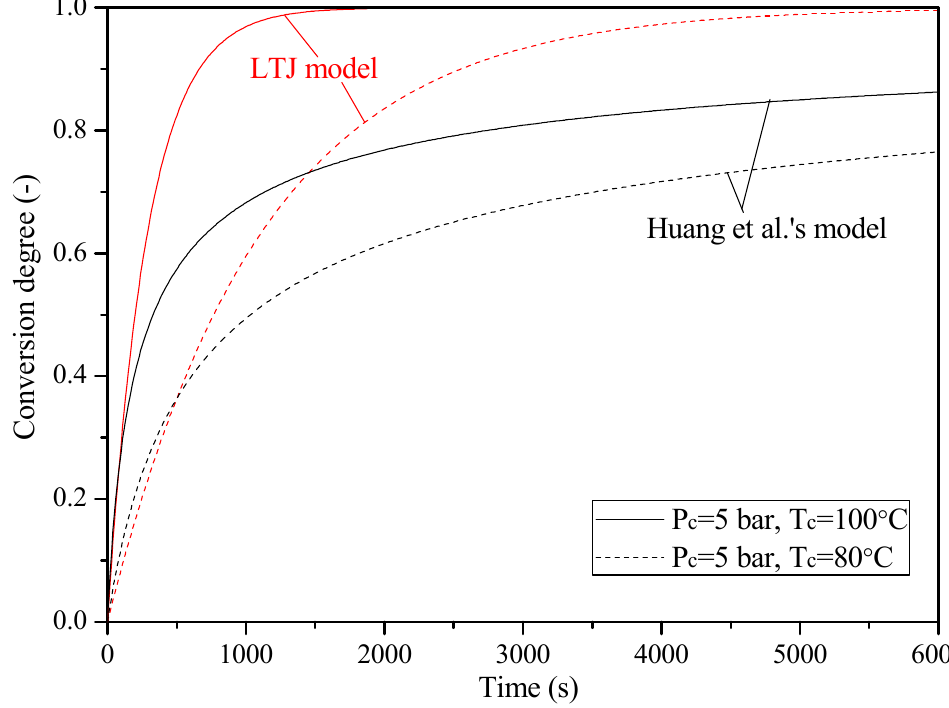
Figure 6. Kinetic curves of SrCl 2 -ammonia desorption based on LTJ model and Huang et al.’s model. The constraint pressure that should be imposed on the sorbent to generate the ammo- nia stream at a required flow rate is shown in Figure 7 when the engine operates with the highest NOx emissions (Mode 8). If using the LTJ model, i.e., the heat and mass transfer of the reactor are under ideal conditions, the unrestrained kinetics enable ammonia release for a longer time, and all the ammonia stored in the sorbent composite can be released, regardless of different reactor layouts; the backpressure of desorption can be almost con- stant, and there is no need for it to go down for the purpose of creating a higher pressure difference to propel ammonia release. The operation duration of the whole unit is almost the same, independent of the heating temperature and layout design. It is noticeable that there is a small point-down tail on the curves of the 10 L reactor; this small tail gradually disappears as the reactor size becomes larger, as shown in Figure 7. Since the LTJ kinetic model has no item directly representing the conversion degree, the calculated conversion degree is solely time-dependent. However, for a comparatively small reactor, the constraint pressure has to decrease to a relatively lower level to release the last bit of ammonia. For a relatively larger reactor, the larger total reactive ammonia ensures that the ammonia dosing can be persistently supplied at a required rate, even when the desorption rate is low as it approaches reaction completion. This is more evident in Equation